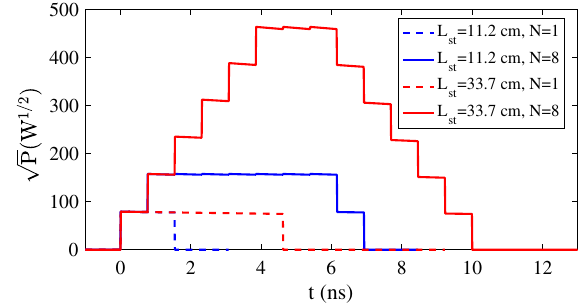
FIG. 3. Calculated square root of the output power using the structure parameters listed in Table I but with various lengths. In